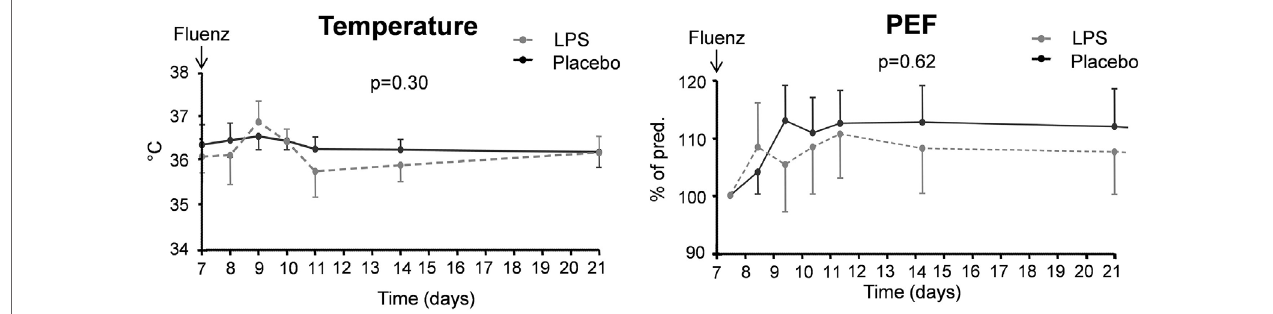
FigUre 12 | Temperature and peak expiratory flow (PEF) in the 26 subjects who were challenged with lipopolysaccharide (LPS) ( n = 13) or placebo ( n = 13) on day 0 and displayed infectivity after inoculation with Fluenz on day 7. Data are represented as geometric mean with 95%